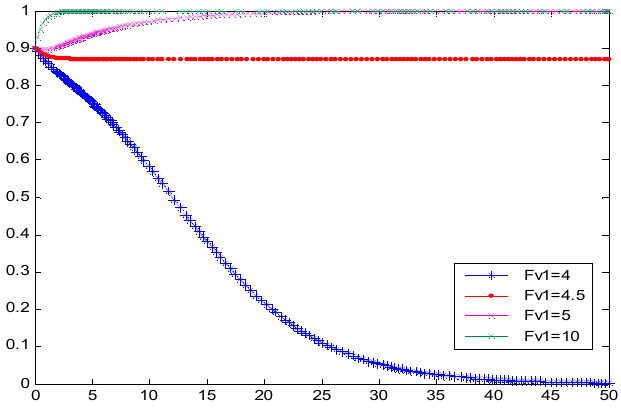
Figure 3. Cooperative probability simulation results of vaccine enterprises under government punishment.